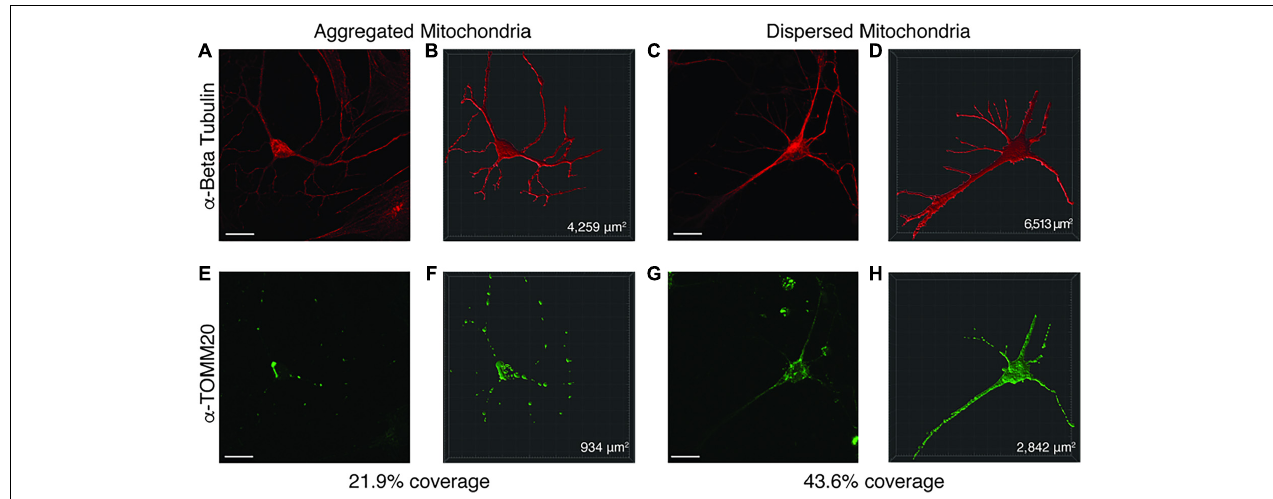
FIGURE 6 | Representative image of Imaris volumetric analysis. Z stacks from neuronal images taken on a Zeiss 810 confocal microscope were loaded into the Imaris software suite for analysis. (A,E) show a representative image of a neuron with mitochondrial aggregates while (C,G) depict a neuron with dispersed mitochondria. Anti-Beta Tubulin (A,C) was used to measure the surface area of the neuron, while anti-TOMM20 (E,G) was used to label total mitochondria content within the neuron. Using the surfaces function in Imaris, a mask for the Beta Tubulin (B,D) and TOMM20 (F,H) stained areas was constructed. From these surface masks, the area is calculated by the software (bottom right corner of B,D,F , H ) for each surface. The mitochondrial area within the neuron was divided by the total neuronal area to determine a percentage of mitochondrial volume. Images were taken at 63 × by confocal microscopy. Scale bar represents 20 µ M.